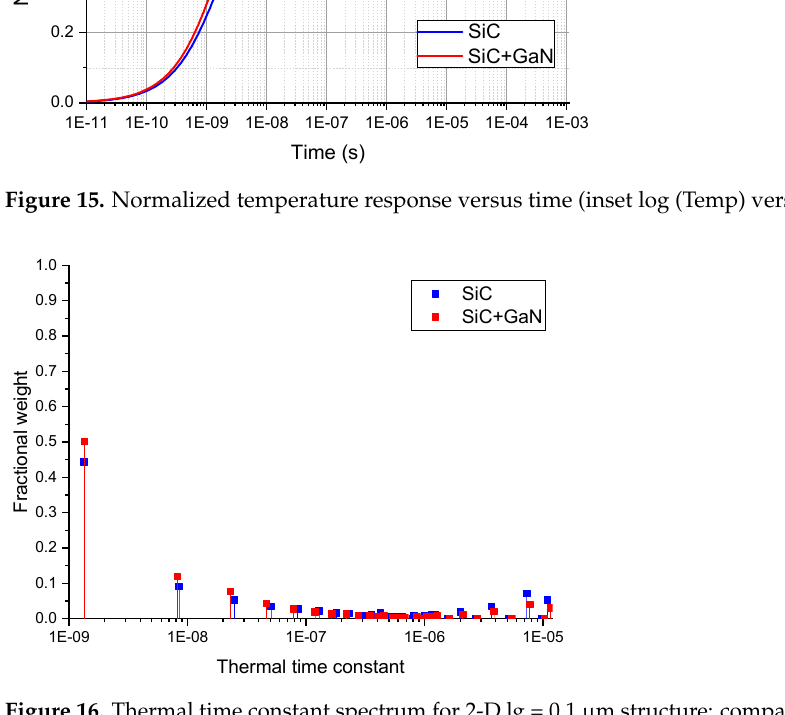
Figure 16. Thermal time constant spectrum for 2-D lg = 0.1 µ m structure: comparison between single layer and 2-layer structure.